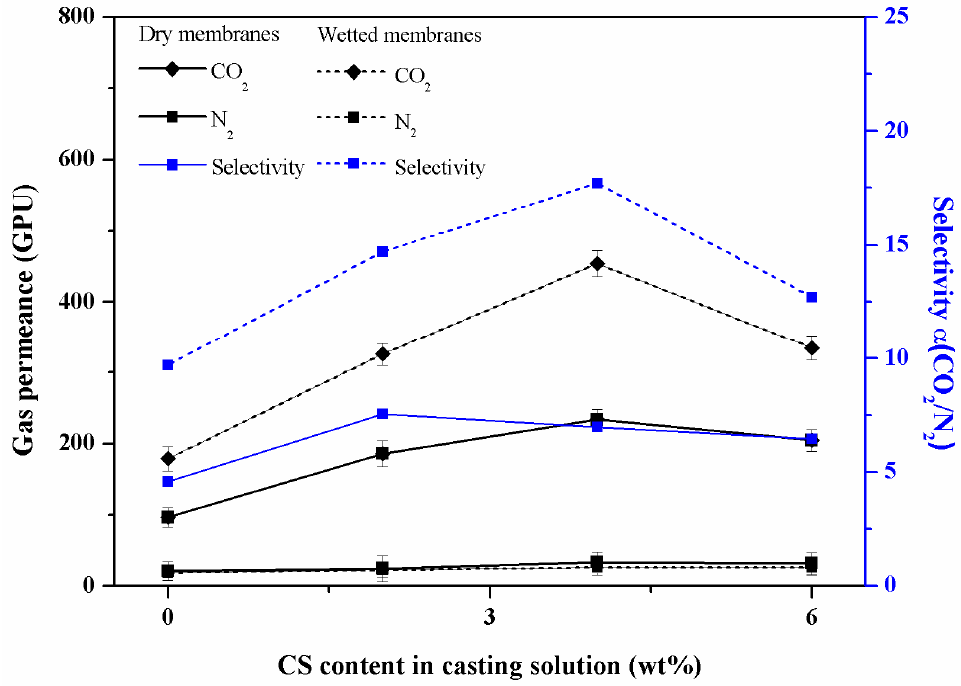
Figure 6. Effect of CS content and moisture on the separation performance of the composite mem- brane.